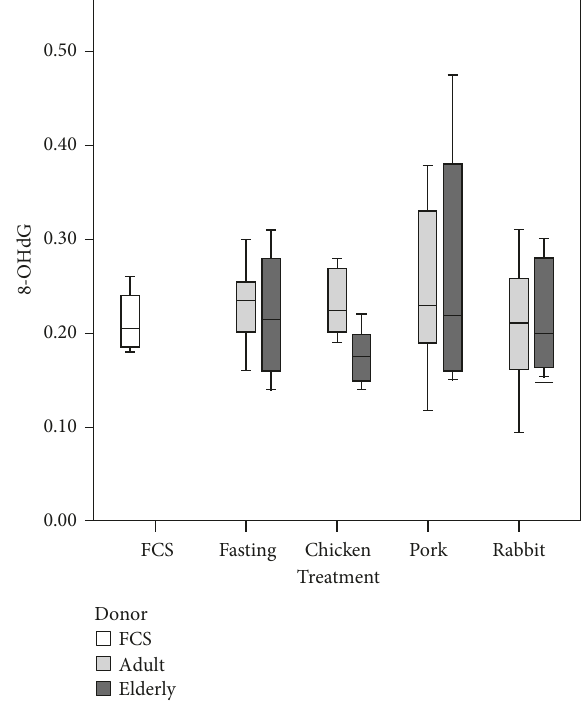
Figure 2: E ff ect of postprandial serum from adult and elderly volunteers after consumption of chicken, pork, or rabbit meat meals on HCAECs oxidative DNA damage (8-OHdG). Data are shown as box plots representing the median, interquartile range, and top and bottom whiskers (highest and lowest case within 1.5 times IQR). No signi fi cant di ff erences were observed by the Kruskal-Wallis test or ANOVA even when data of postprandial sera are considered together and compared to fasting sera. Samples used for the experiments were n = 6 (elderly) and n = 10 (adult). Each sample was run as a technical duplicate. For control condition in fetal calf serum (FCS), n = 4